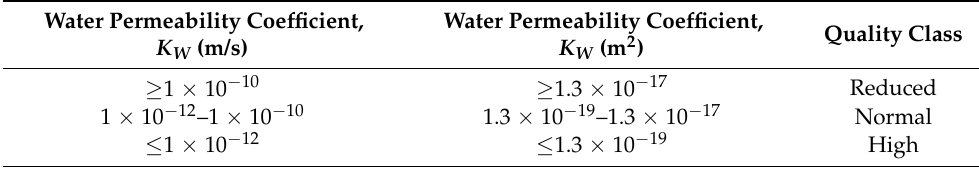
Table 21. Quality class of concrete as a function of its water permeability coefficient. Water Permeability